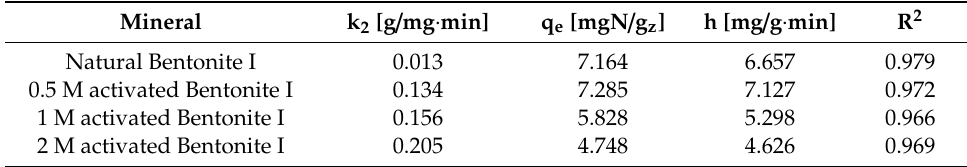
Table 3. The kinetic parameters for ammonium ion exchange using the Langmuir model (0.5 M, 1 M, and 2 M indicate NaCl concentrations of 0.5, 1.0, and 2.0 mol / L, respectively).